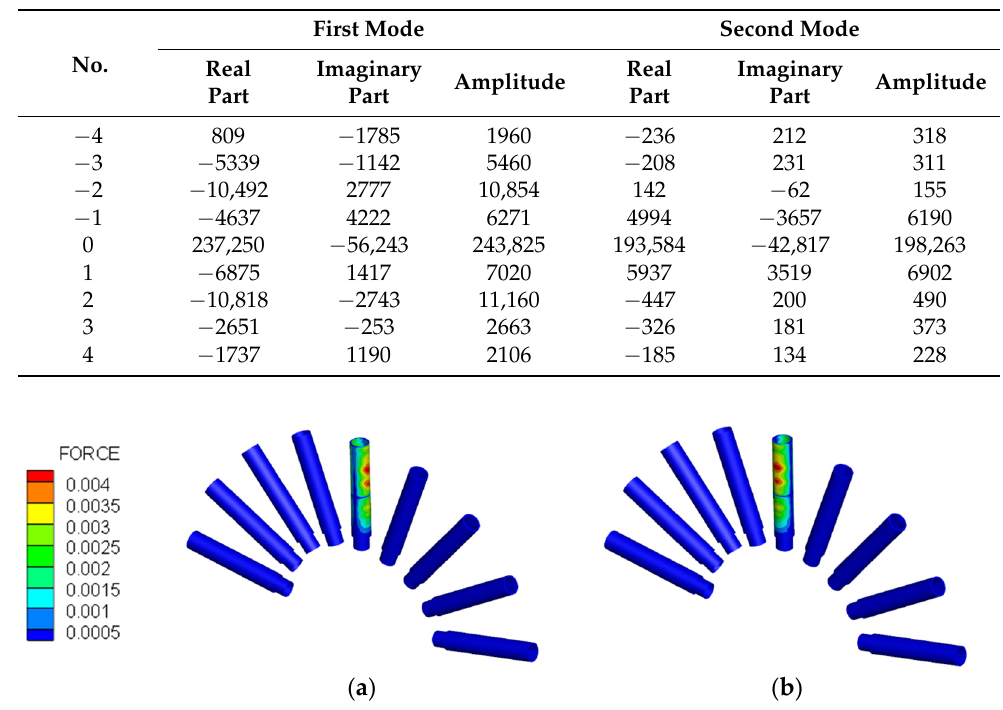
Table 4. Aerodynamic influence coefficients.